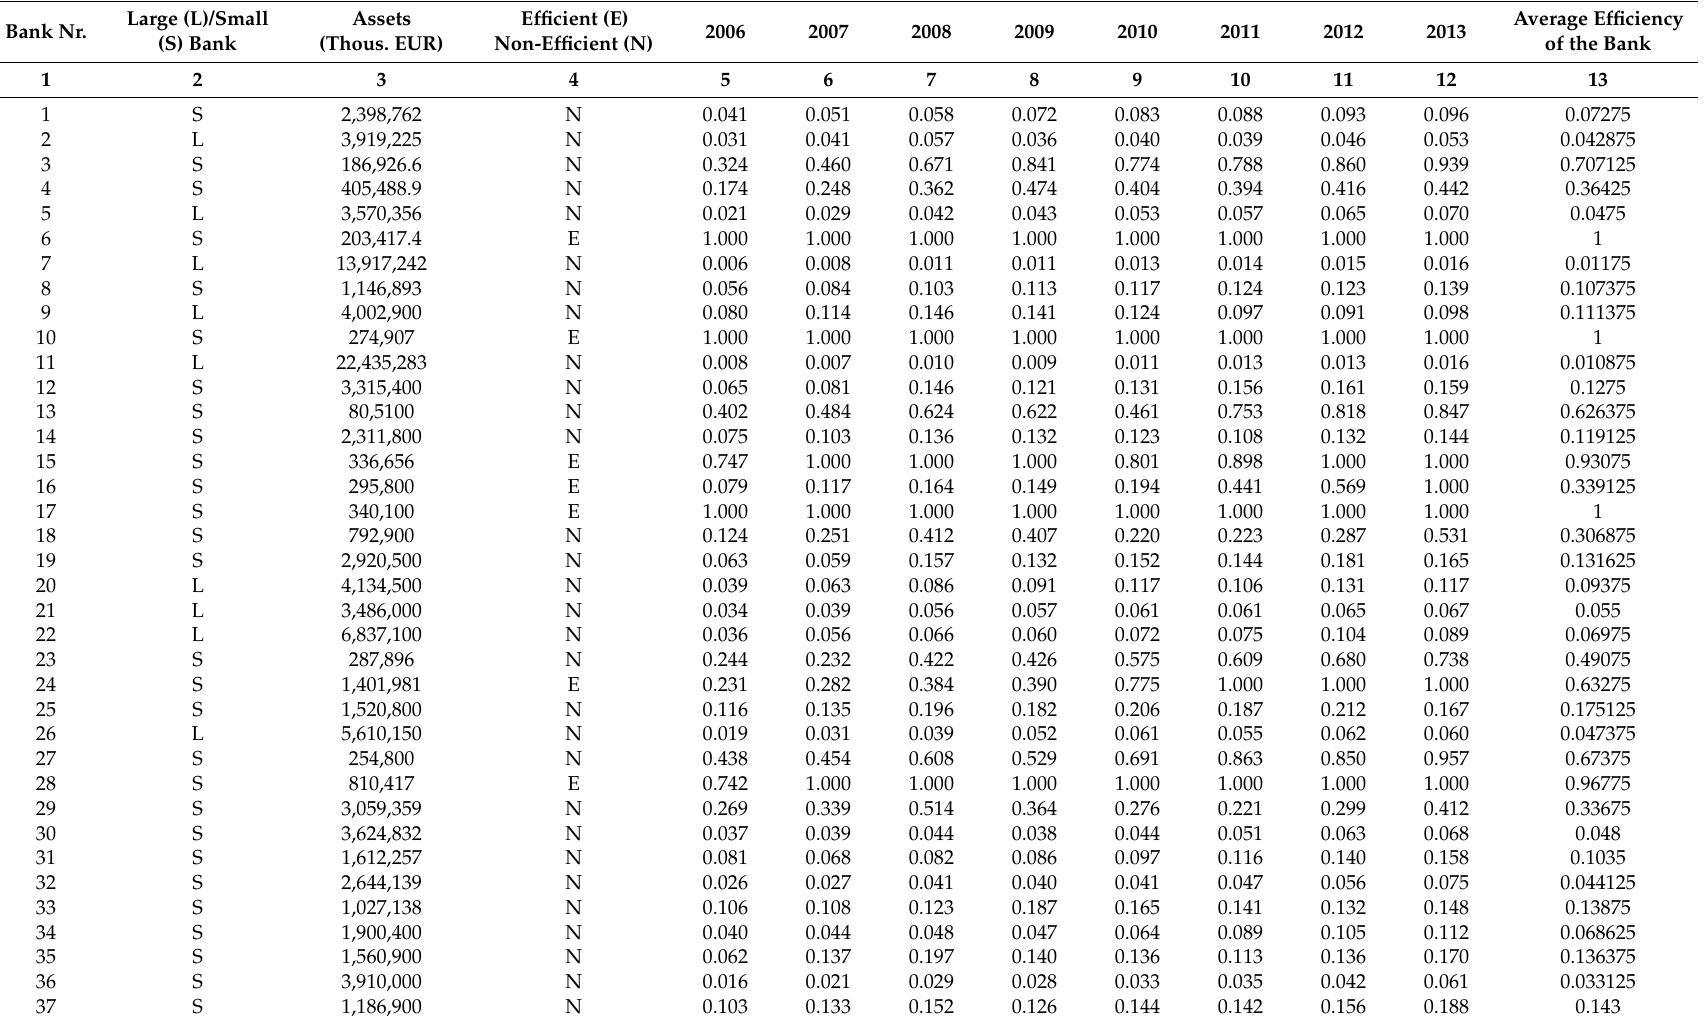
Table 5. Efficiency1 of individual banks (net interest margin as an output).